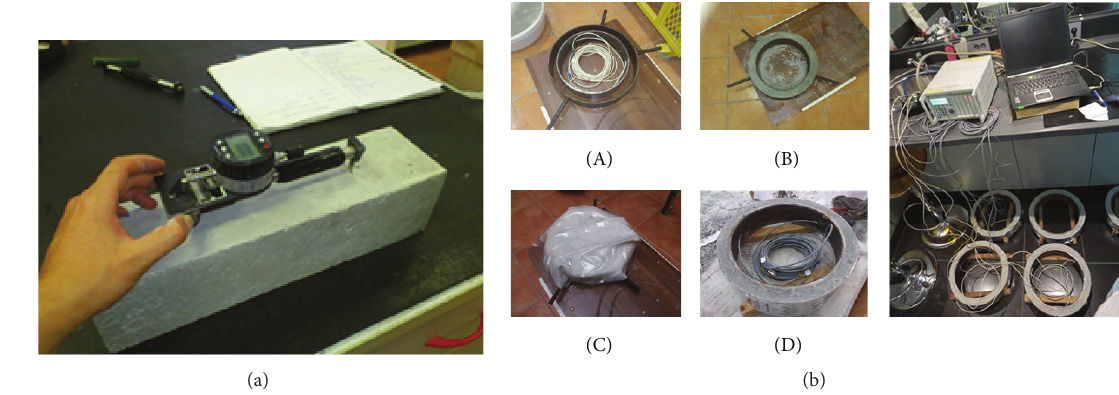
Figure 4: (a) Measurement of total shrinkage by mobile displacement transducer. (b) Test setup for restrained shrinkage.